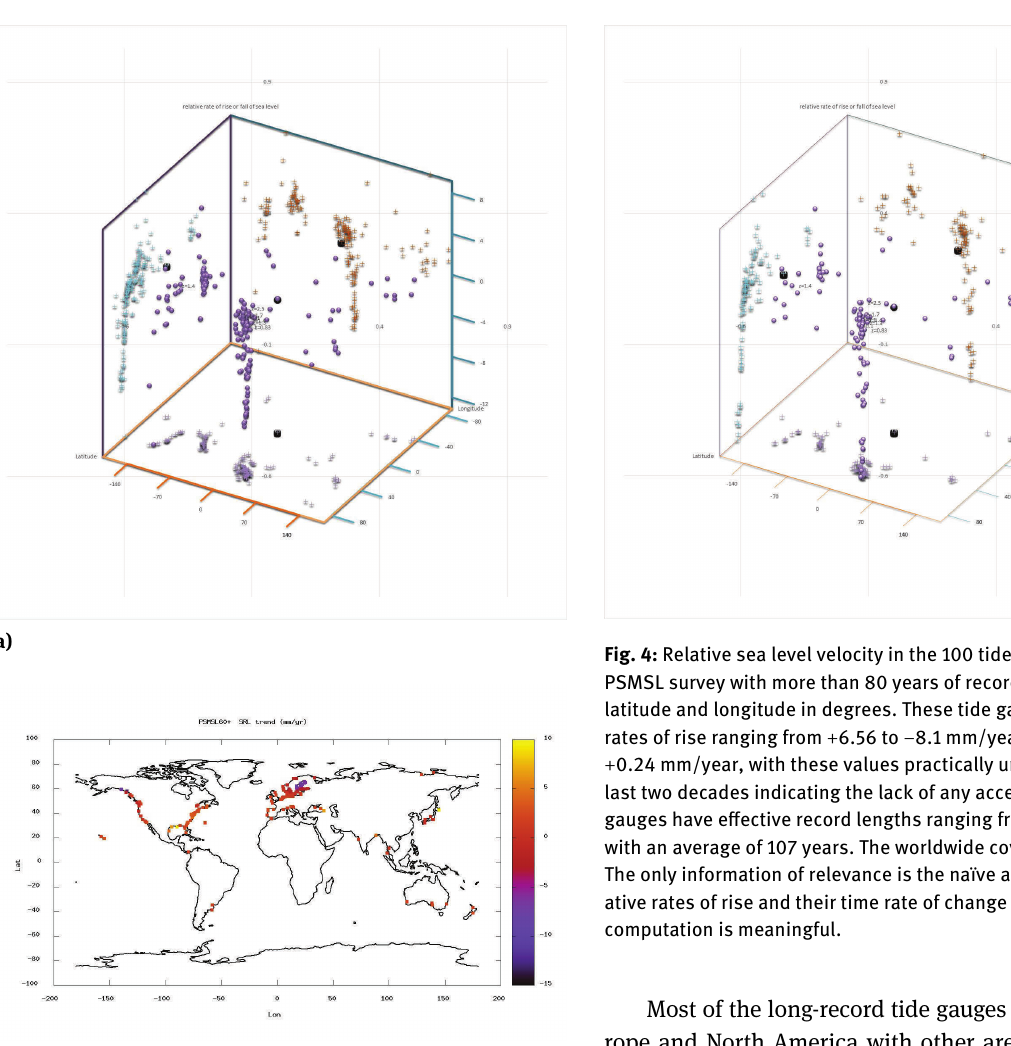
Fig. 3: Relative sea level velocity in the 170 tide gauges of the latest PSMSL survey with more than 60 years of recording in mm/year vs. latitude and longitude in degrees. a) latitude-longitude-vertical velocity space. b) tide gauge location in the world map. For this situation, there are presently (2013) 170 tide gages to consider, of average number of years recorded 91.04, average completeness 93.72% and relative rates of rise running from + 9.21 mm/year to − 13.08 mm/year with an average estimation of 0.25 mm/year. The worldwide coverage is poor.